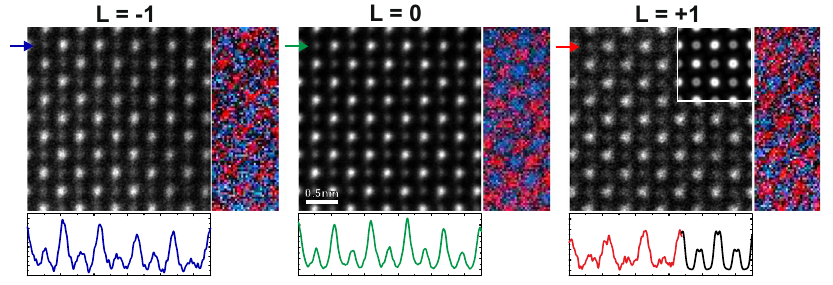
Figure 3. Scanning transmission electron microscopy and spectroscopy performance using single vortex beams on SrTiO 3 . All STEM images are acquired with electron probes that carry different OAMs (L = − 1, L = 0, L = + 1, from left to right) as provided by the novel optical setup. Right insets show false-color elemental maps of Ti (red) and Sr (blue) as obtained from EELS at the Ti-L and Sr-M edges. The lower panels show HAADF intensity profiles across the images at positions marked by an arrow. A further inset that is embedded in the HAADF image for the L = + 1 eVB (right row) shows the result of an ADF simulation for a sample thickness of 20 nm and a source size broadening of the L = + 1 beam of 30 pm. The intensity profile of this simulation is also included as a black line section in the lower